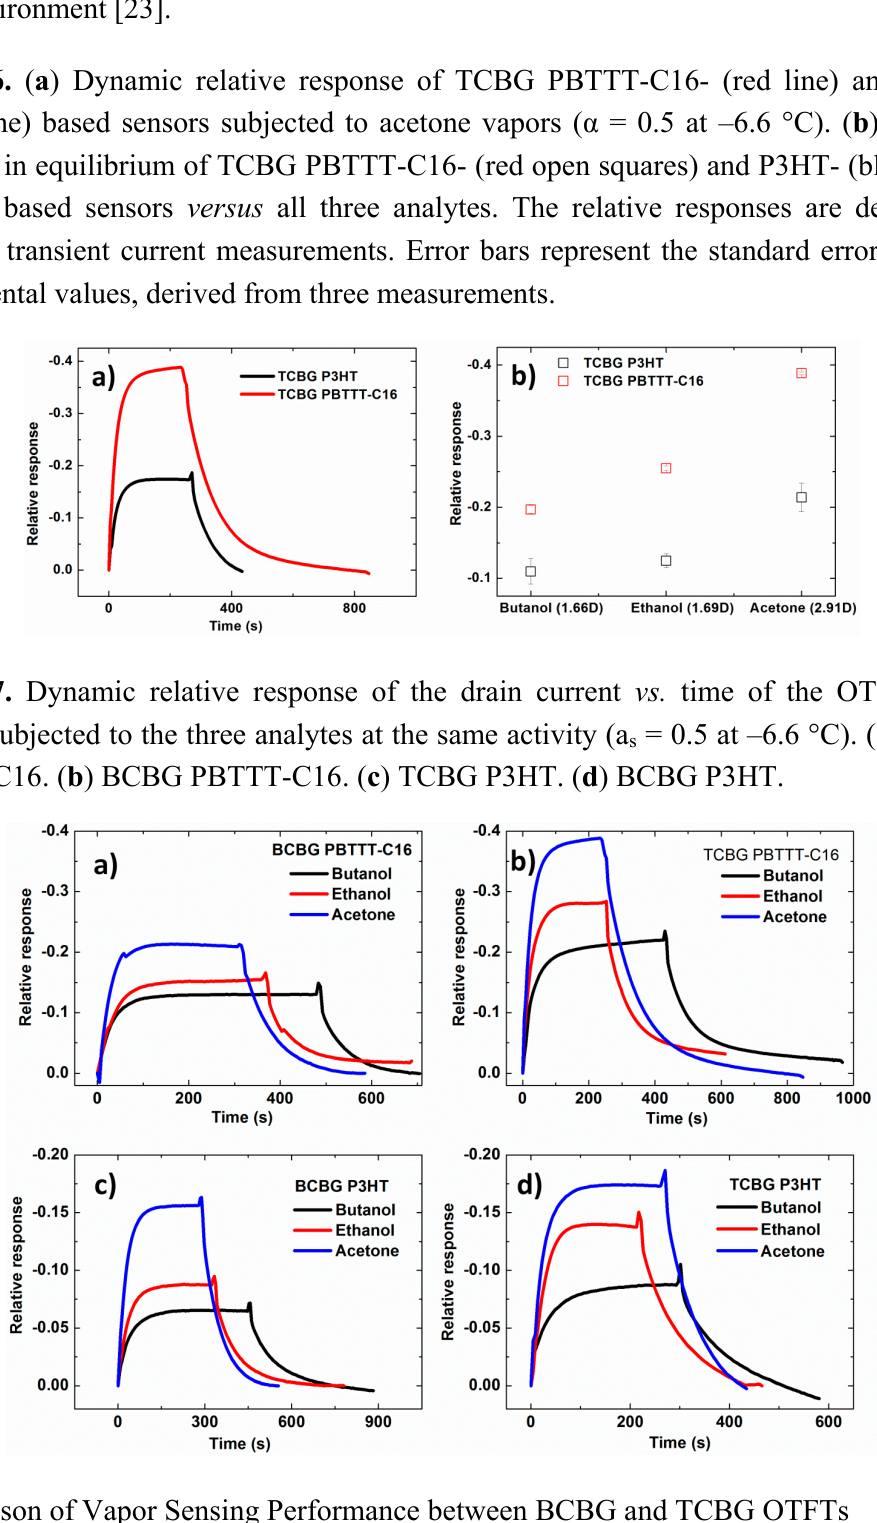
Figure 6. ( a ) Dynamic relative response of TCBG PBTTT-C16- (red line) and P3HT- (black line) based sensors subjected to acetone vapors (α = 0.5 at ‒6.6 °C). ( b ) Relative response in equilibrium of TCBG PBTTT-C16- (red open squares) and P3HT- (black open squares) based sensors versus all three analytes. The relative responses are determined from the transient current measurements. Error bars represent the standard error of mean experimental values, derived from three measurements.